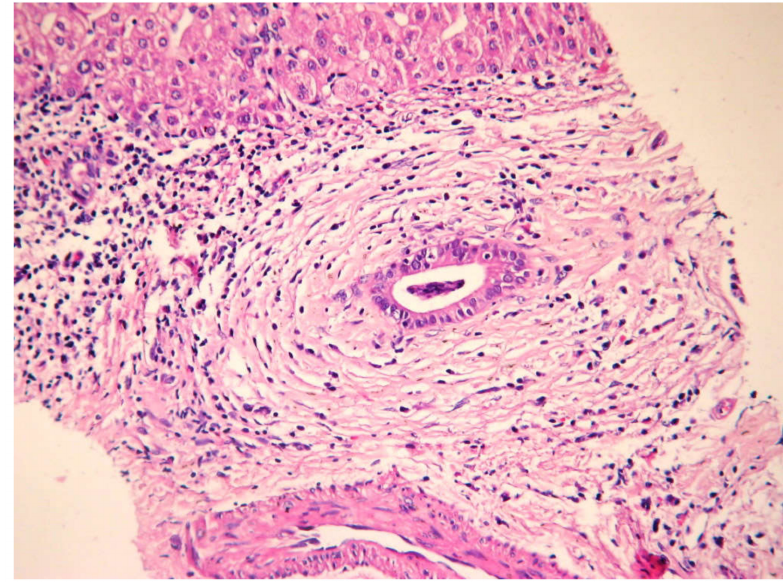
Figure 3. Portal space with periductal fibrosis and moderate inflammation hematoxylin eosin (HE) 200 ×